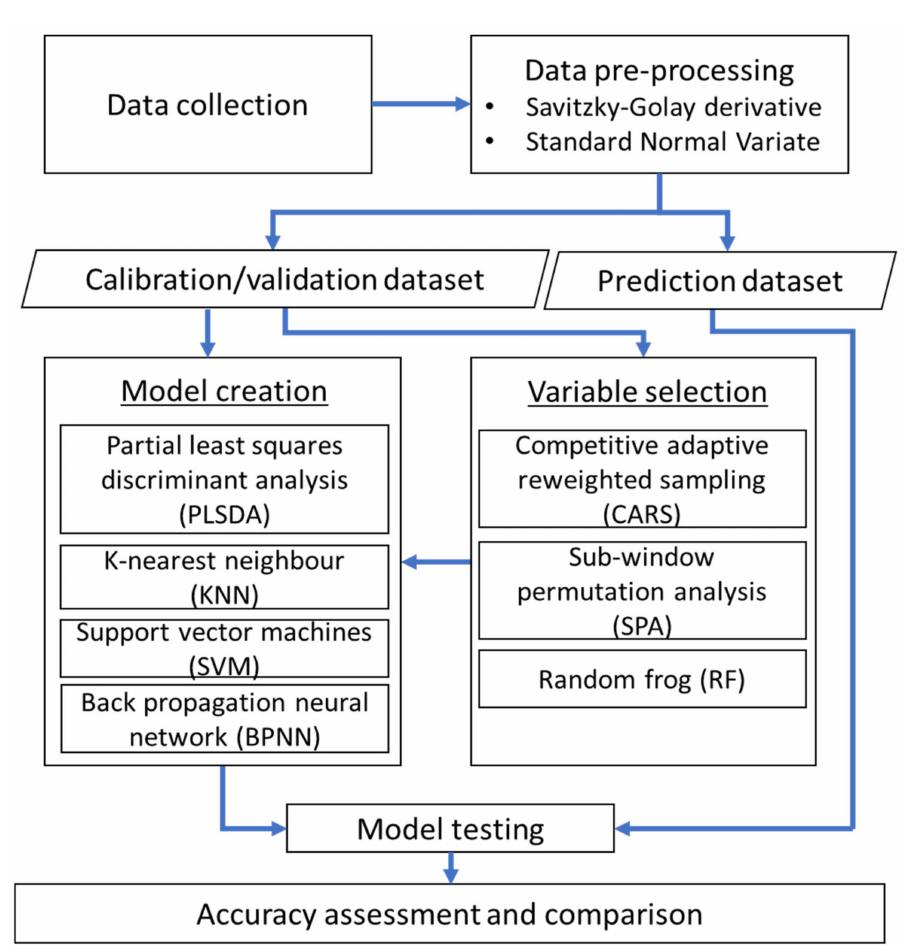
Figure 3. Flowchart of key steps for testing spectral discrimination modelling approaches and variable selection methods (wavelength reduction) for the detection of mite infestations on banana